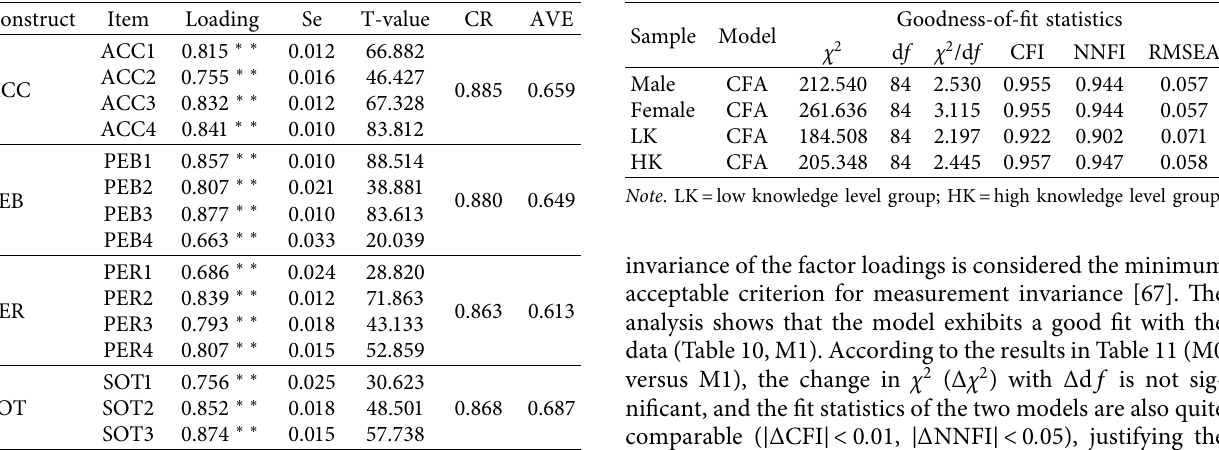
Table 7: Goodness-of-fit statistics